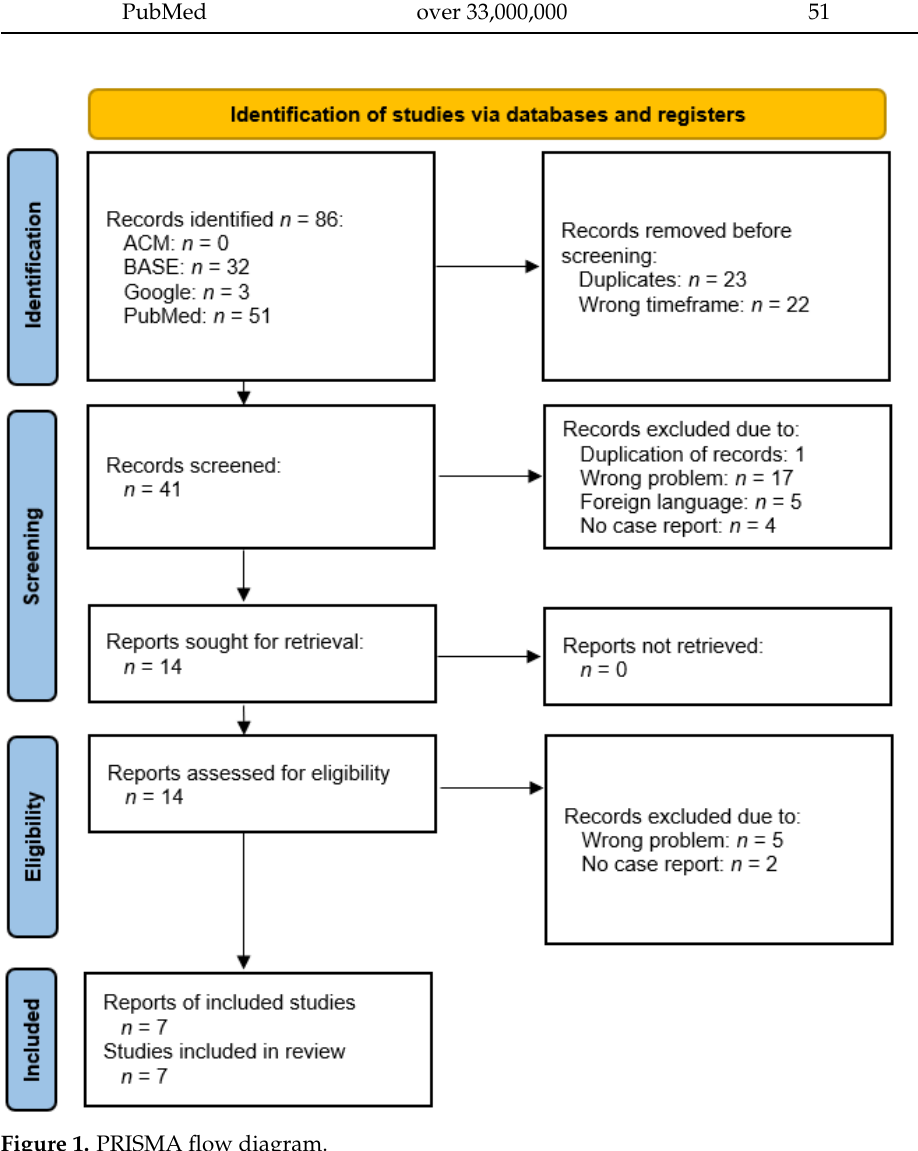
Figure 1. PRISMA flow diagram.